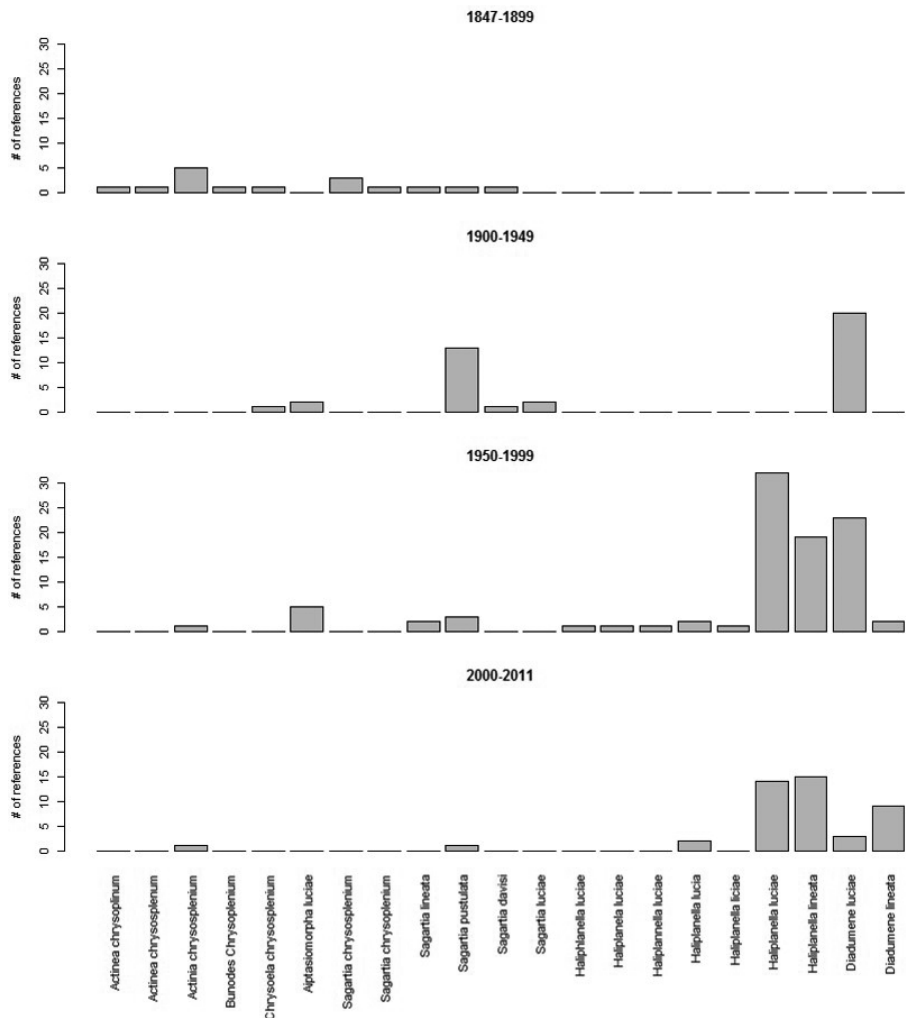
Figure 6. Histogram showing the shift in name usage over time. In the time period 2000-2011, Diad- umene lineata showed the greatest increase in usage. Data compiled from Fautin